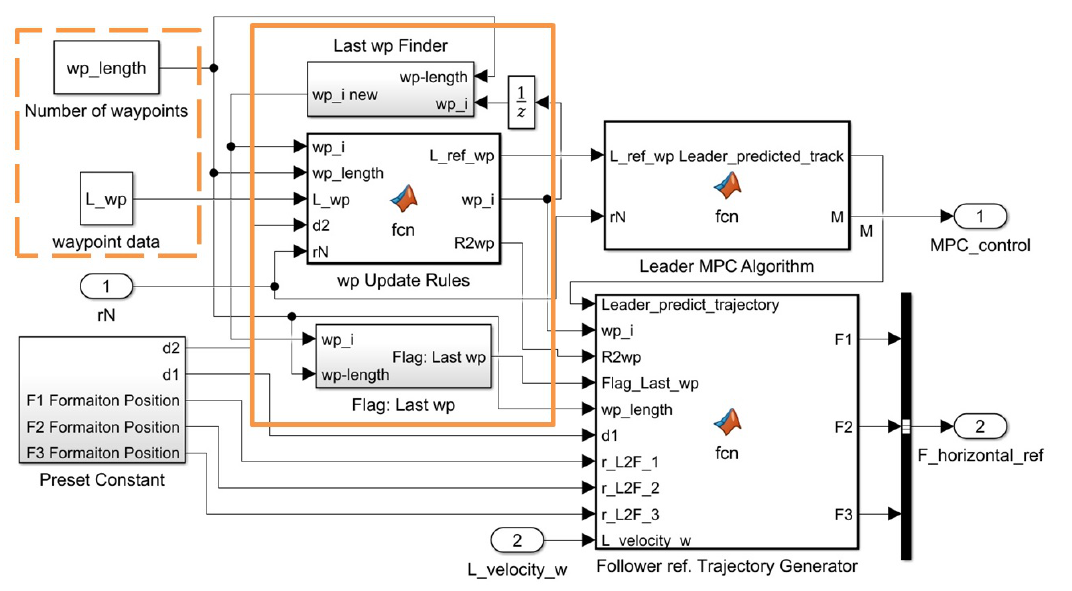
Figure 10. Configuration of leader’s horizontal motion control.